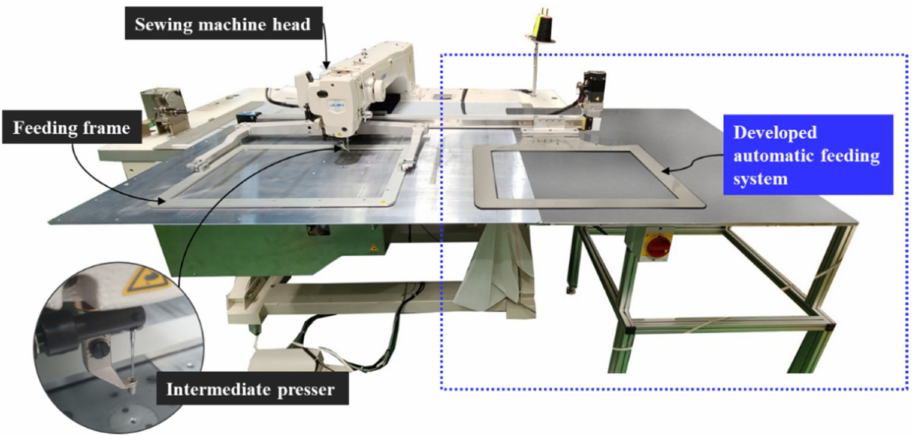
Figure 1. Industrial sewing machine and developed automatic feeding system.